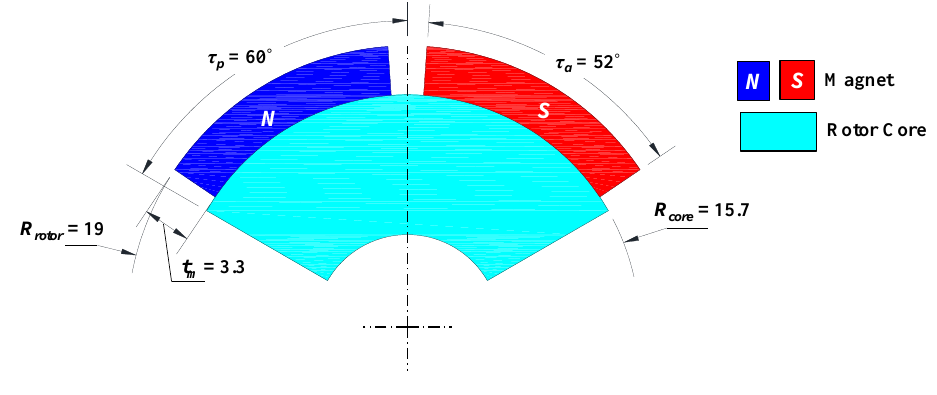
Figure 5. Base model. Table 2. Design parameters of base model.